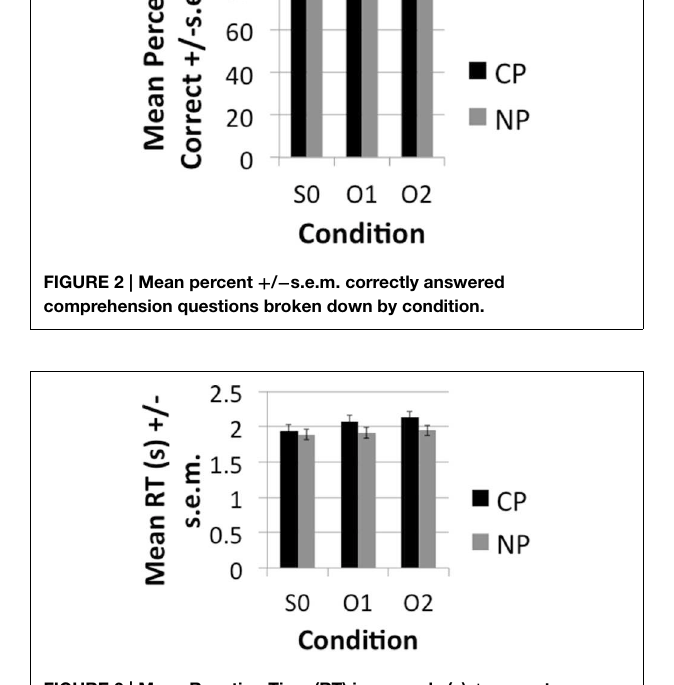
19 . 23, p < 0 . 001] and items [ F 2(1 , 39) = 28 . 9] analyses and an